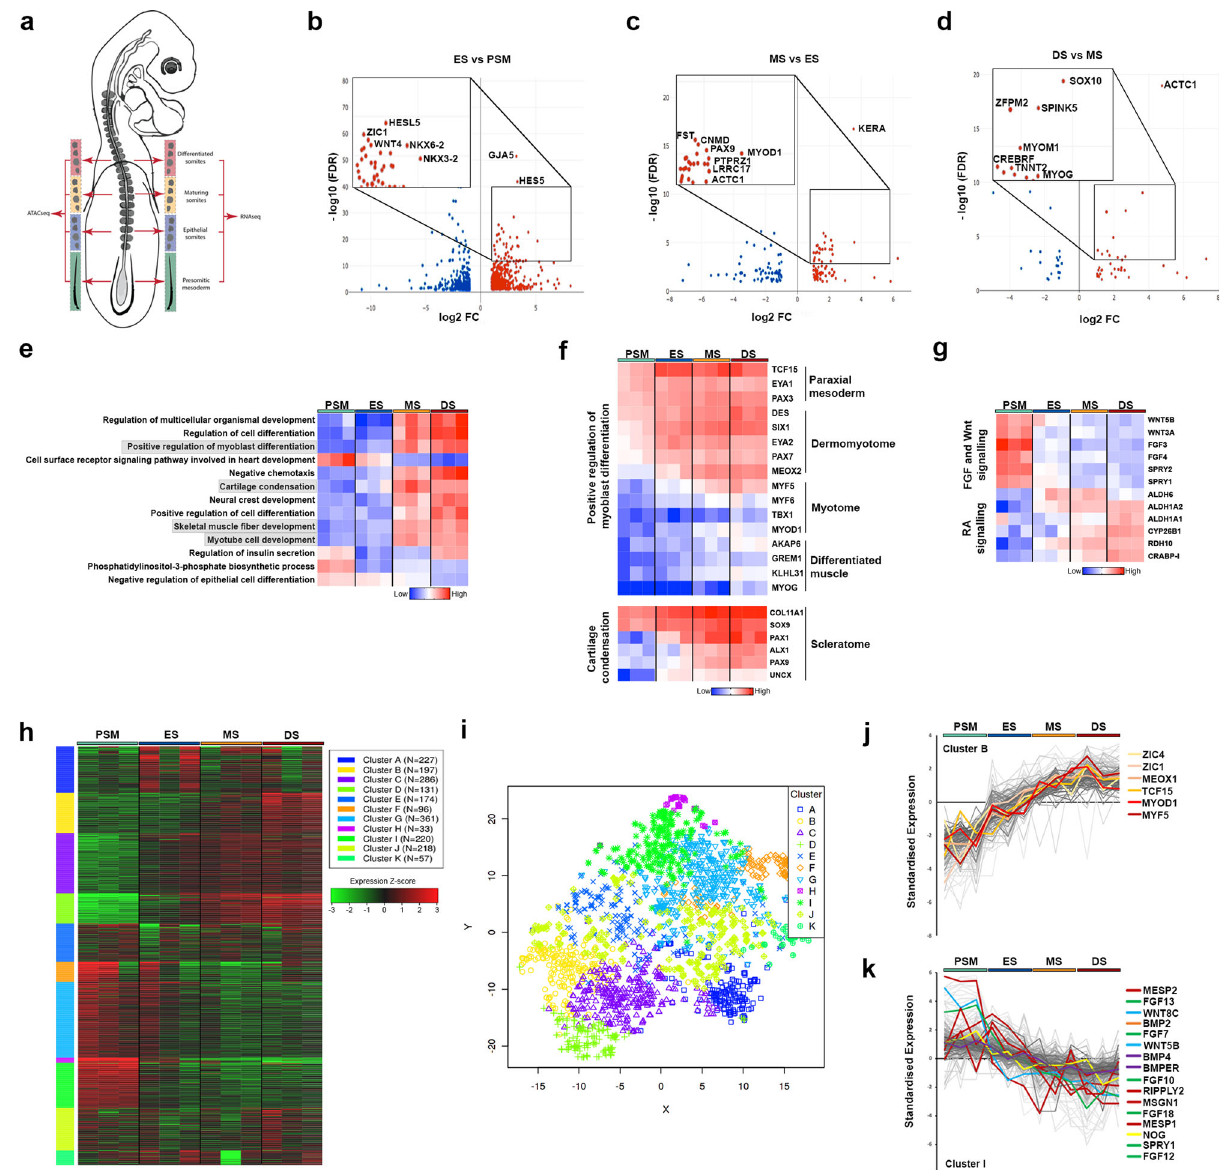
Fig. 1 Transcriptional pro fi ling of developing somites. a Schematic representation of HH14 chick embryo with presomitic mesoderm (PSM), epithelial somite (ES), maturing somite (MS) and differentiated somite (DS) dissected for RNA-seq and ATAC-seq, in triplicate. b – d Volcano plots showing enriched genes (log fold change >1.5) comparing PSM with ES, ES with MS, and MS with DS. e Heat map showing GO terms associated with PSM or DS enriched genes. f Clusters of highly correlated genes identi fi ed for myoblast differentiation and cartilage condensation. g Wnt, FGF and retinoic acid (RA) signalling pathways are shown in heat map. h Heat map showing k-means linear enrichment clustering across PSM, ES, MS and DS. i Dimension reduction algorithm t-SNE used to map top genes in each cluster determined by k-means. j Cluster B and k Cluster I are shown with some genes labelled to identify key transcription factors and signalling